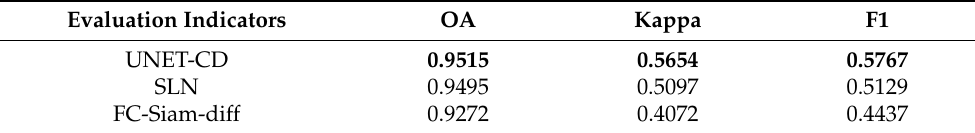
Table 4. Accuracy comparison of change detection results.